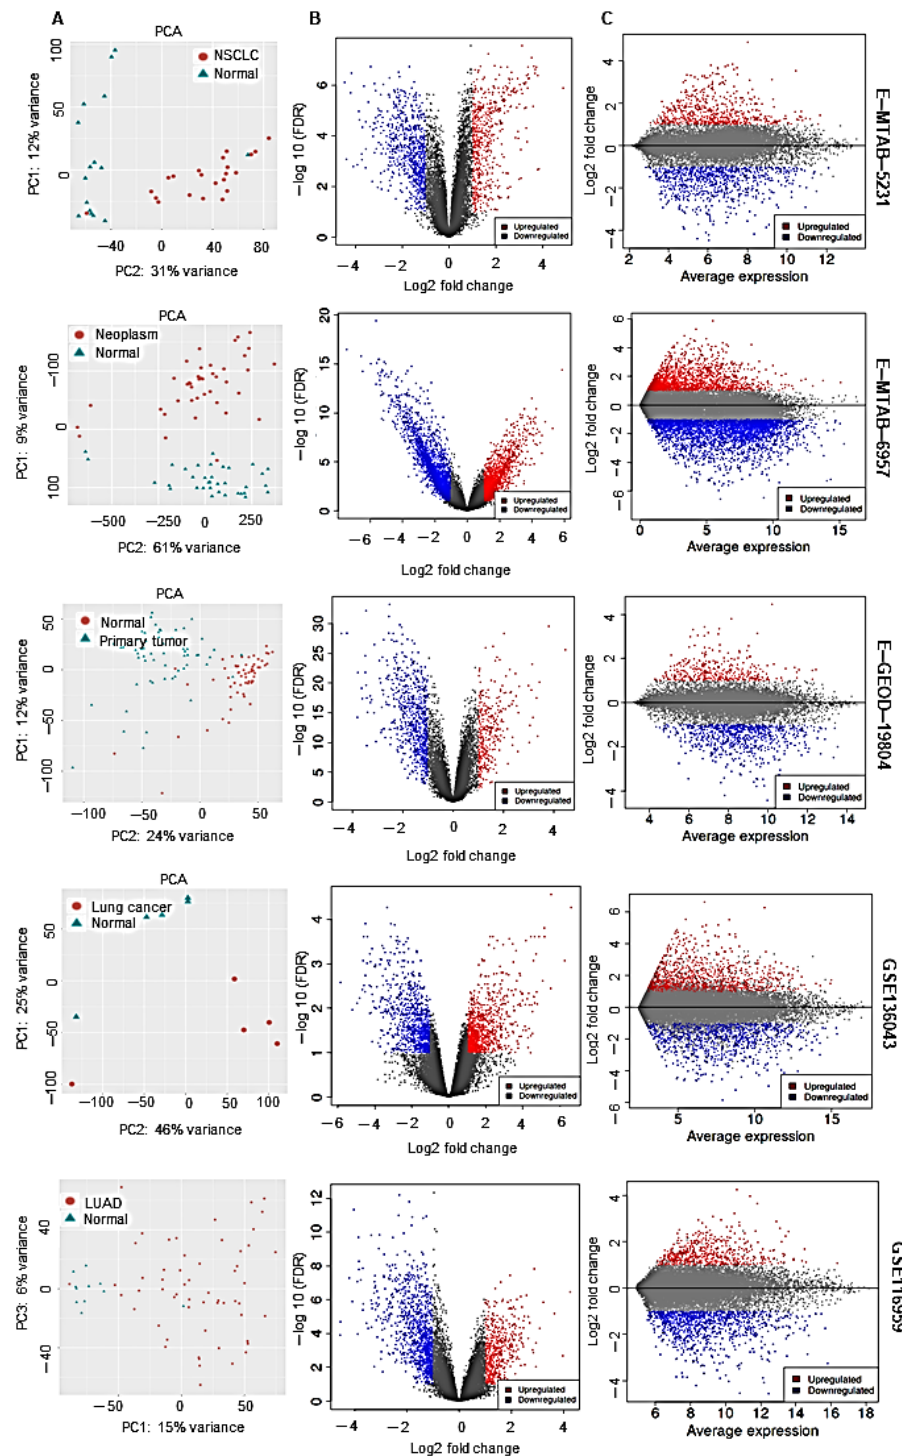
Figure 3. Differential gene expression analysis of data sets. ( A ) principal component analysis showing clustering of samples; ( B ) volcano plot showing differential expression of genes against false discovery rate between lung cancer and normal lungs; ( C ) MA plot (M: log ratio, A: Mean average) showing average expression of genes against fold change between lung cancer and normal lungs in respective data sets indicated to the